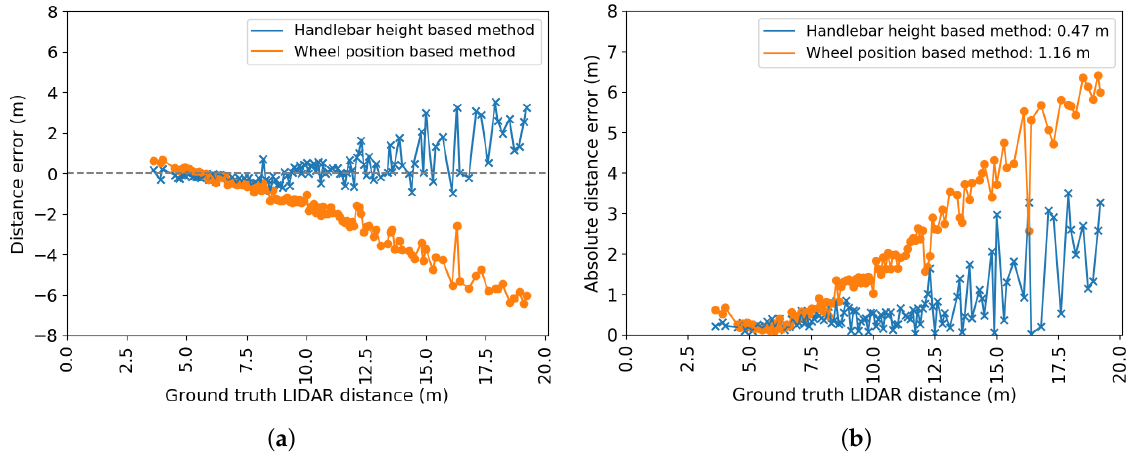
Figure 13. Error plots for the dynamic test for both distance estimation methods. ( a ) Signed error; ( b ) absolute